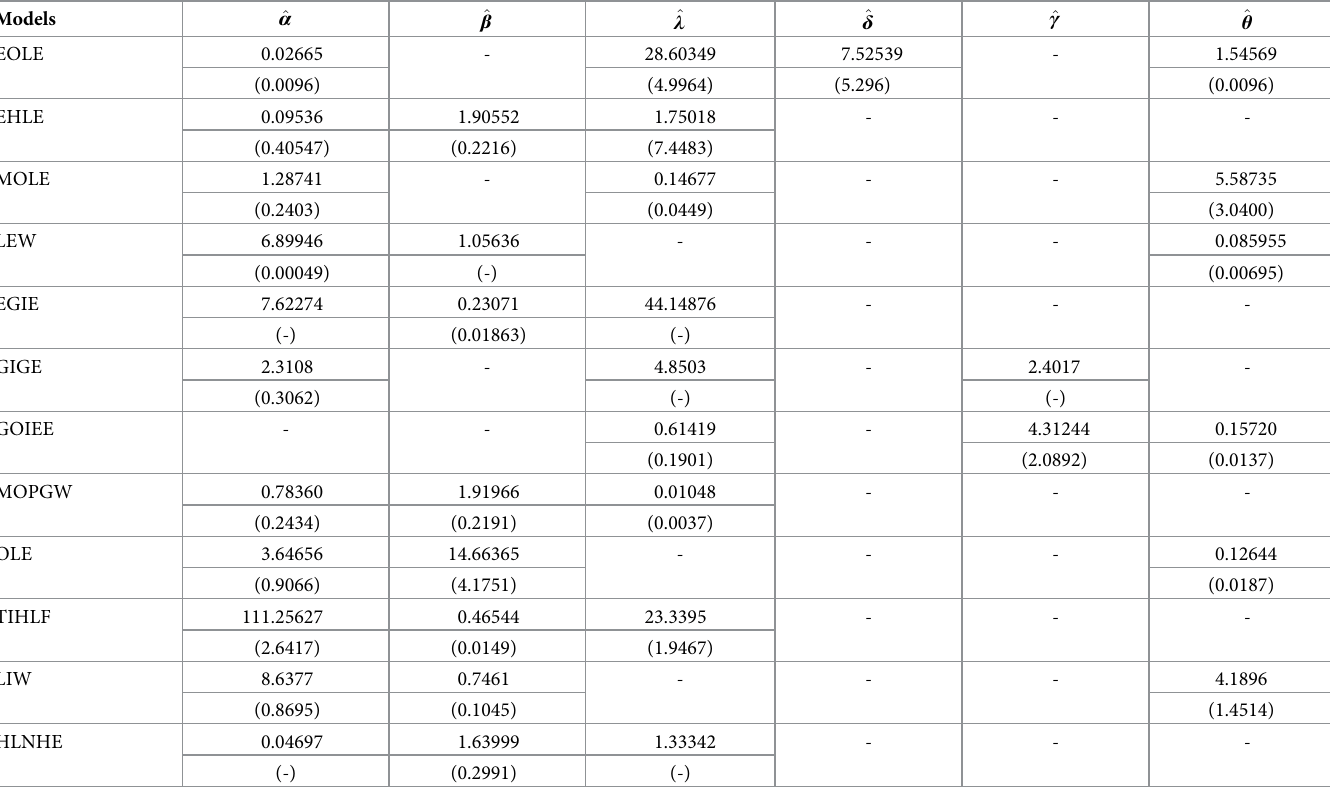
Standard error in parenthesis.